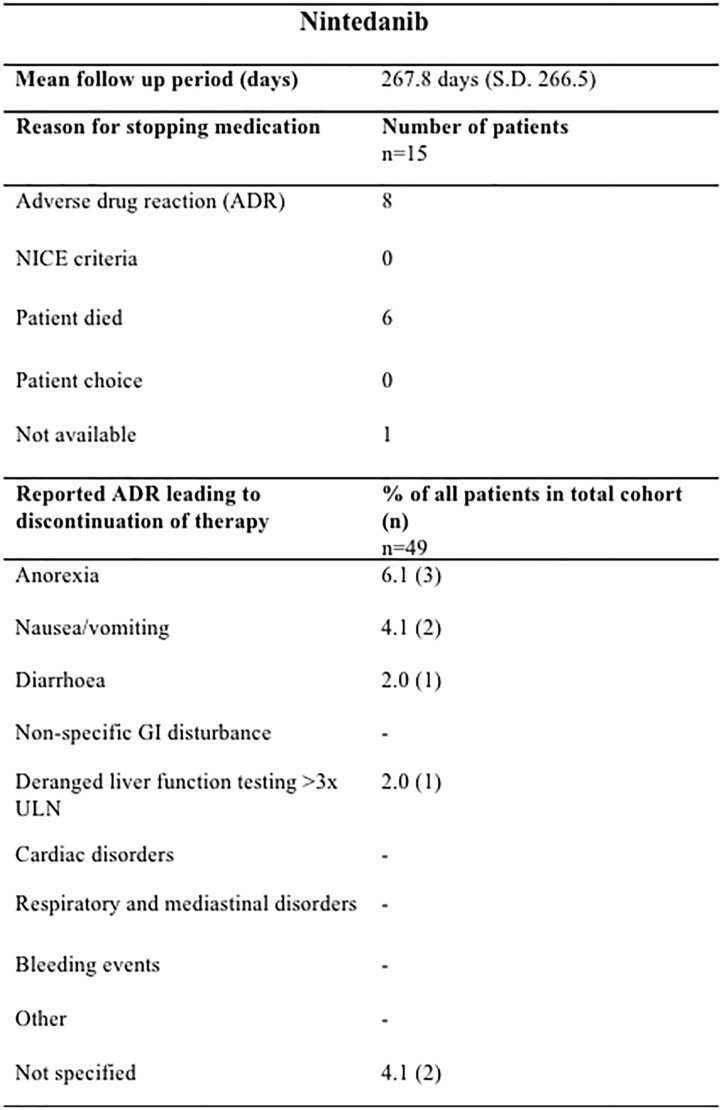
Documented reasons for cessation of Nintedanib therapy during the study with a mean duration of follow up of 267.8 days (SD 266.5). In the cohort studied, 15/49 patients terminated therapy, most commonly due to ADRs (8/15) but also due to patient death (6/15). Anorexia (3 ADRs), nausea (2 ADRs) and weight loss (2 ADRs) were most commonly reported in our cohort. n, number; GI, gastrointestinal; ULN, upper limit of normal.